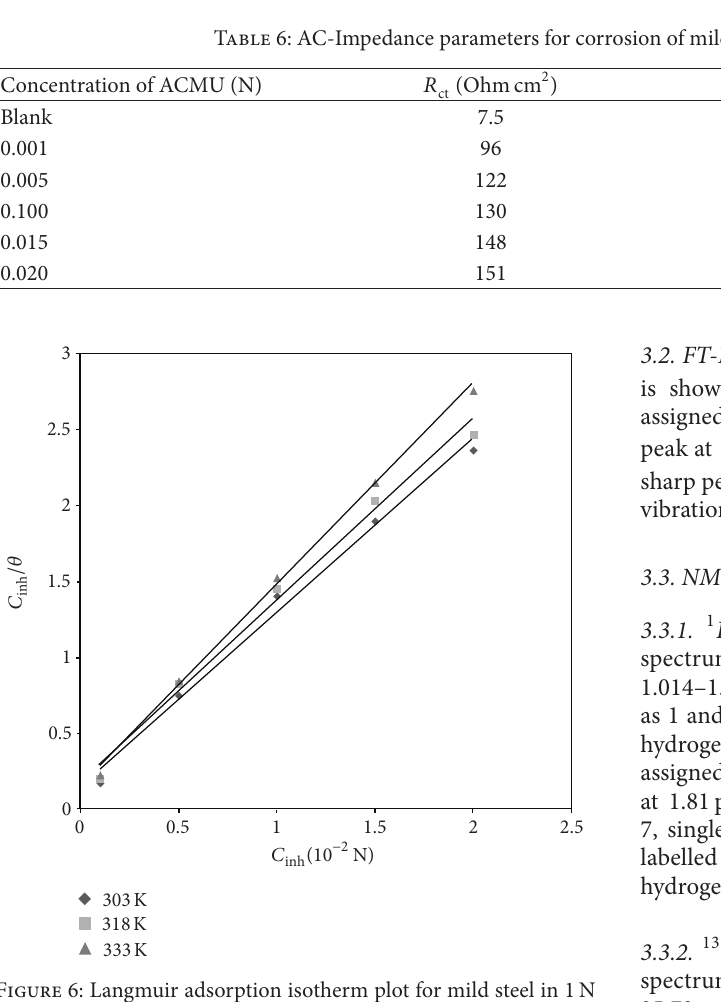
T 5: Corrosion parameters of mild steel in 1N H